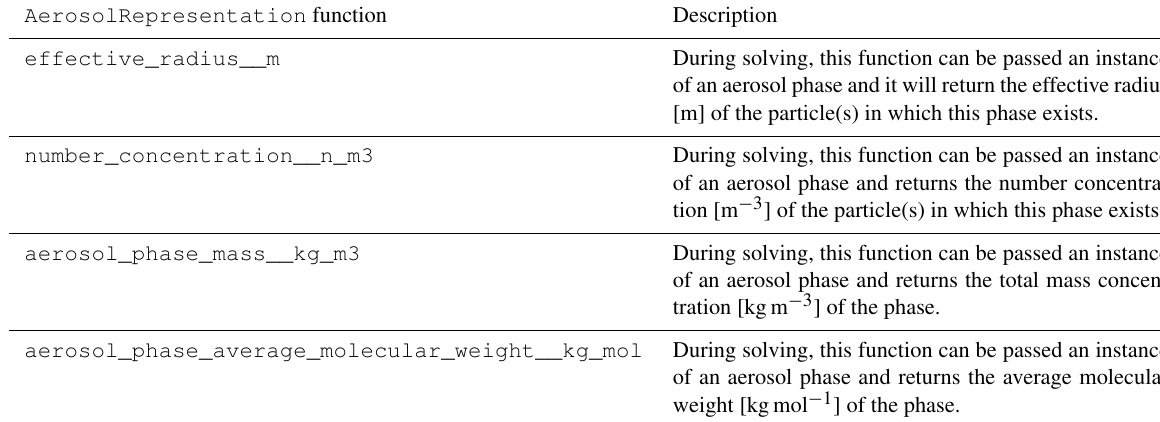
Table 5. Primary functions of the AerosolRepresentation base class and its subclasses. In addition to returning the property requested, each of these functions can also return the partial derivatives of the property with respect to the solver variables for use in calculating the Jacobian of the forcing.